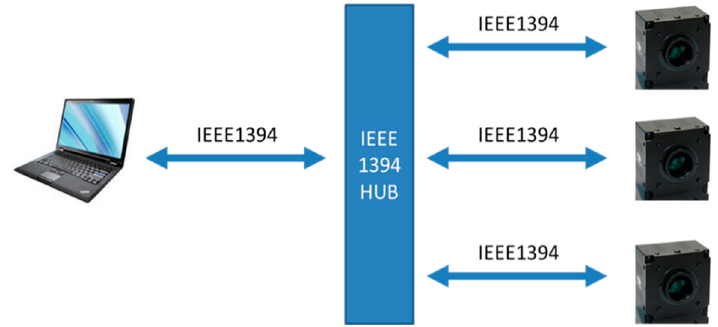
Figure 1. Hardware structure of the system.